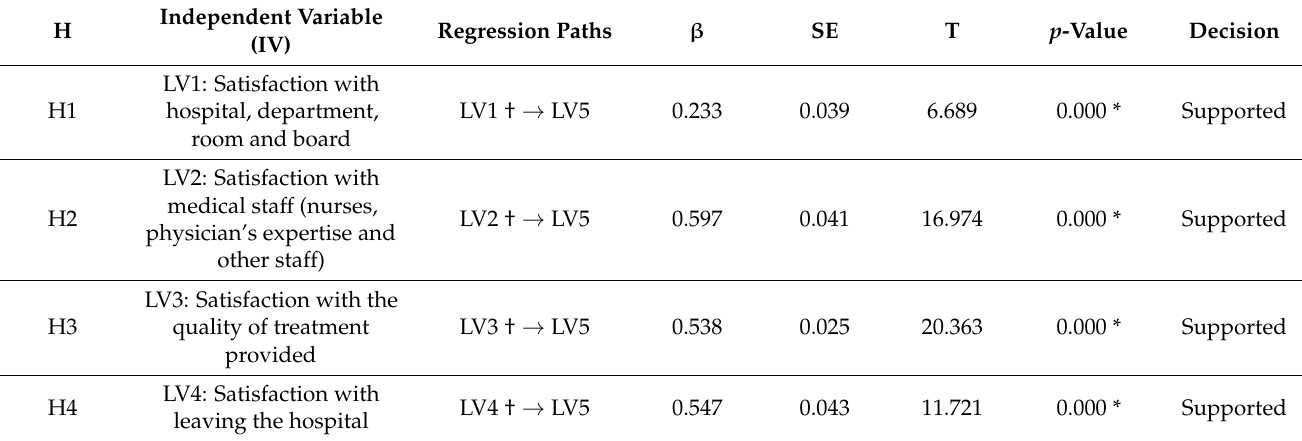
Table 3. Hypothesis